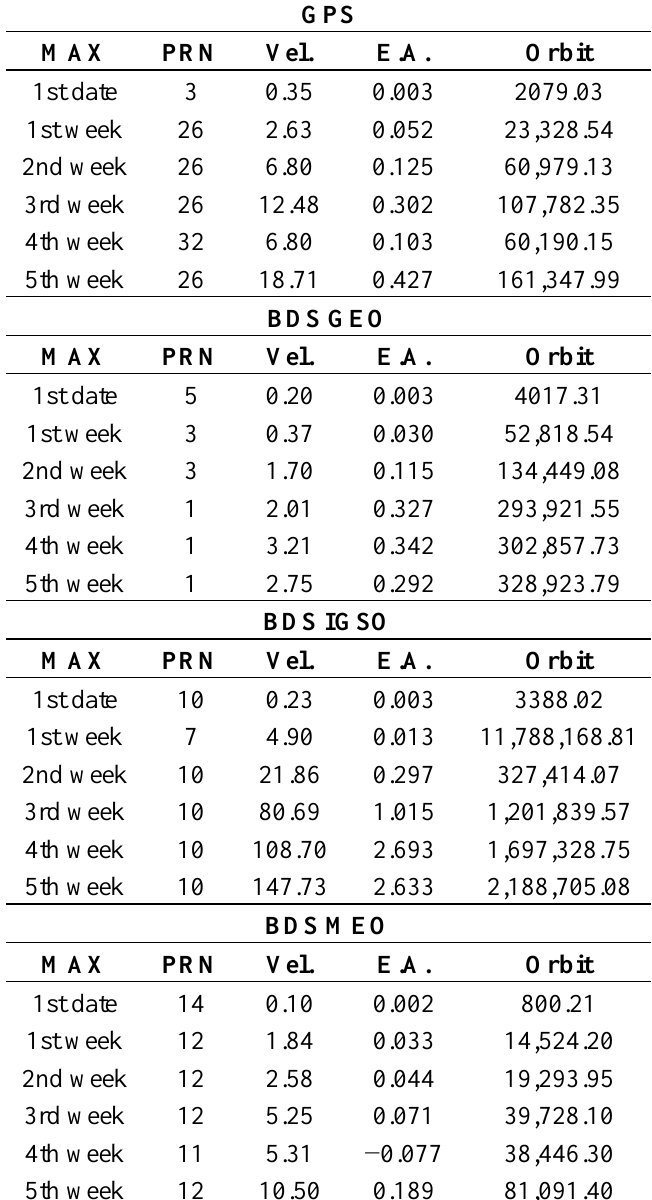
Table 7. DQA5 statistic